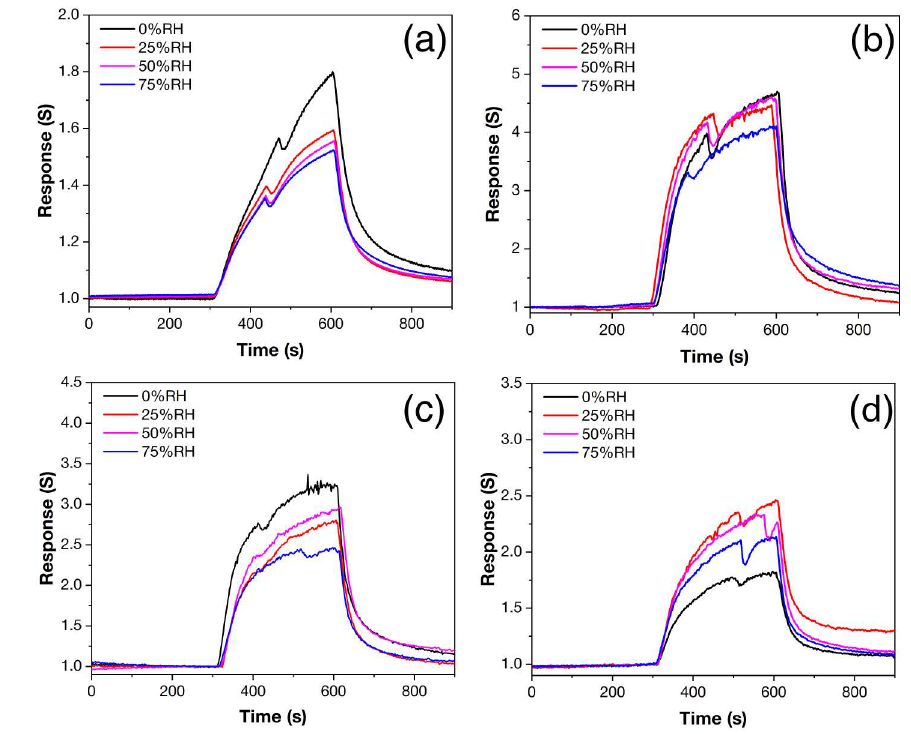
Figure 11. Response to 500 ppb NO 2 at 175 ◦ C and 0–75% RH of ZnO/Fe 2 O 3 thin films: Z ( a ), Z1Fe ( b ), Z2Fe ( c ), and Z3Fe ( d ).